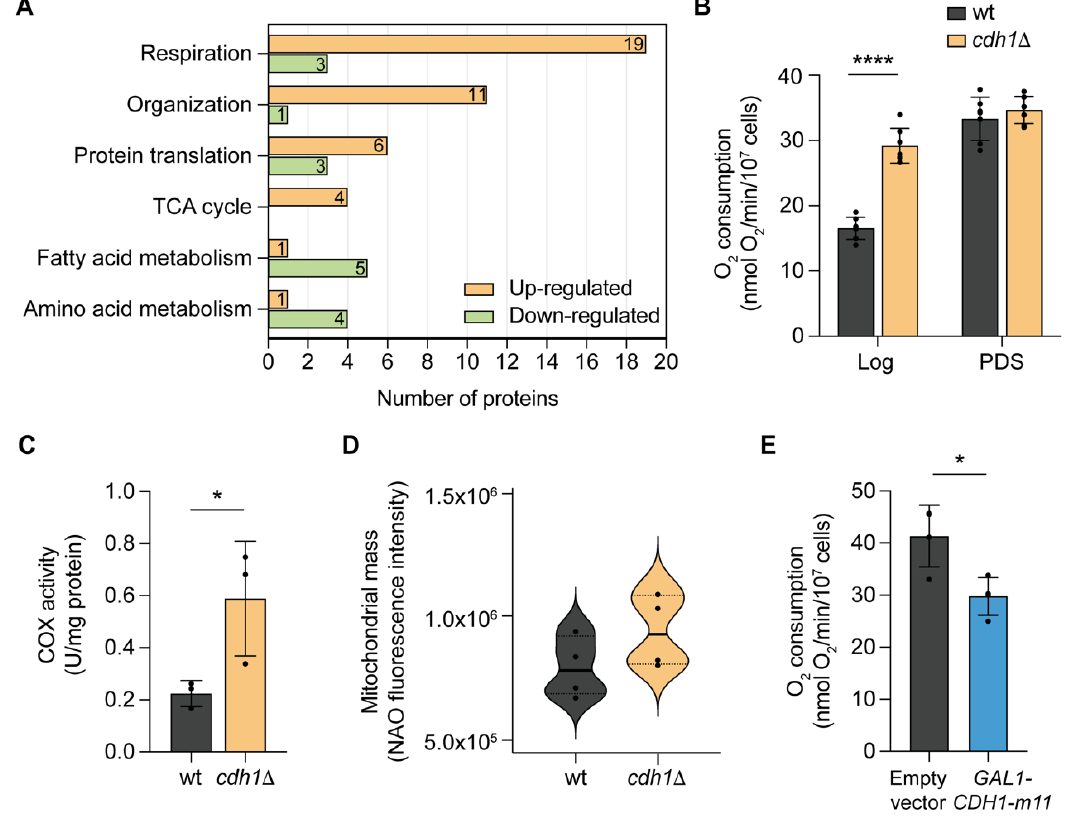
Figure 2. CDH1 deletion promotes a metabolic remodeling towards an increased respiratory metabolism. ( A ) Gene ontology (GO)-term enrichment analysis on biological processes for sta- tistically altered proteins using STRING v11.0. ( B ) Cells were grown until mid-log or post-diauxic shift (PDS) phase and the respiratory rate was obtained measuring oxygen consumption rate in whole cells. Values are the mean ± SD ( n = 7); ****, p < 0.0001; t -test. ( C ) Cells were grown until mid-log phase and cytochrome c oxidase activity was determined by following the rate of cytochrome c oxidation. Values are the mean ± SD ( n = 3); *, p < 0.05; t -test. ( D ) Cells were grown until early-log phase and the mitochondrial mass was determined by staining the cells with the dye nonyl acridine orange (NAO) and analyzed by flow cytometry ( n = 4). ( E ) For the Cdh1p overexpression assay, cells were grown in raffinose media until mid-log phase and oxygen consumption rate measured after